Question: Does the plotted quantity increase or decrease?
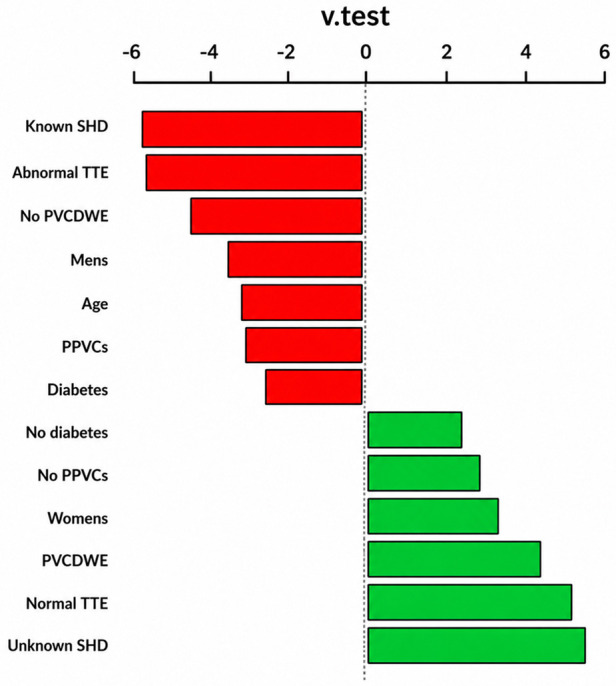
Answer: decreasing